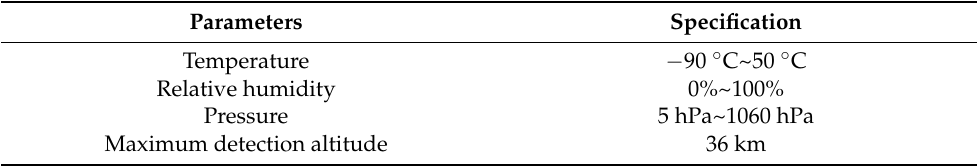
Table 2. The specifications of the GTS1 Digital Radiosonde.